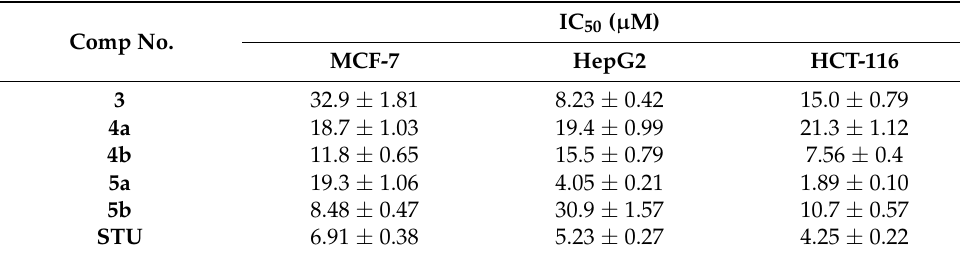
Table 1. In vitro antitumor activity of quinolone derivatives 3 , 4a , b and 5a , b over MCF-7, HepG2 and HCT-116, cell lines. Data are expressed as the mean ± SD. Comp